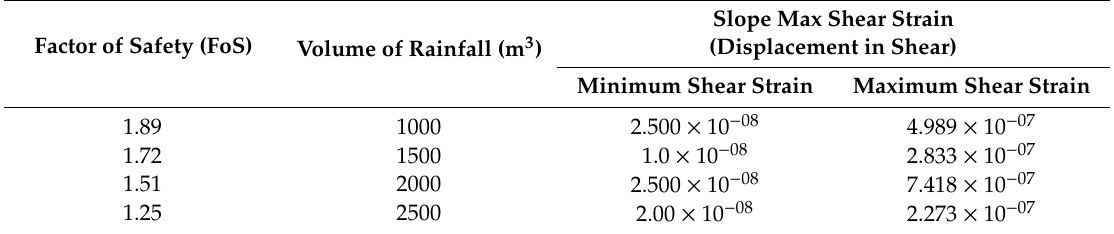
Table 7. General results of FLACSlope simulations in clay soil slope.